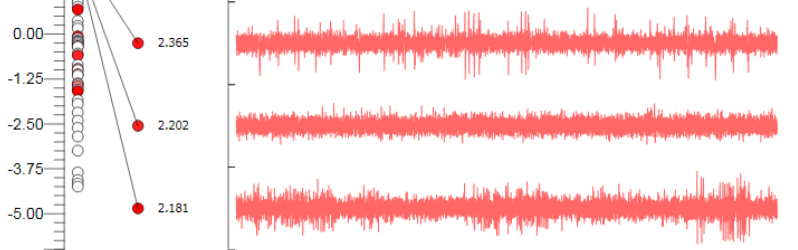
Figure 10. Microelectrode recording appearance of the subthalamic nucleus signal; note the increase in background activity, with high amplitude irregular firing.